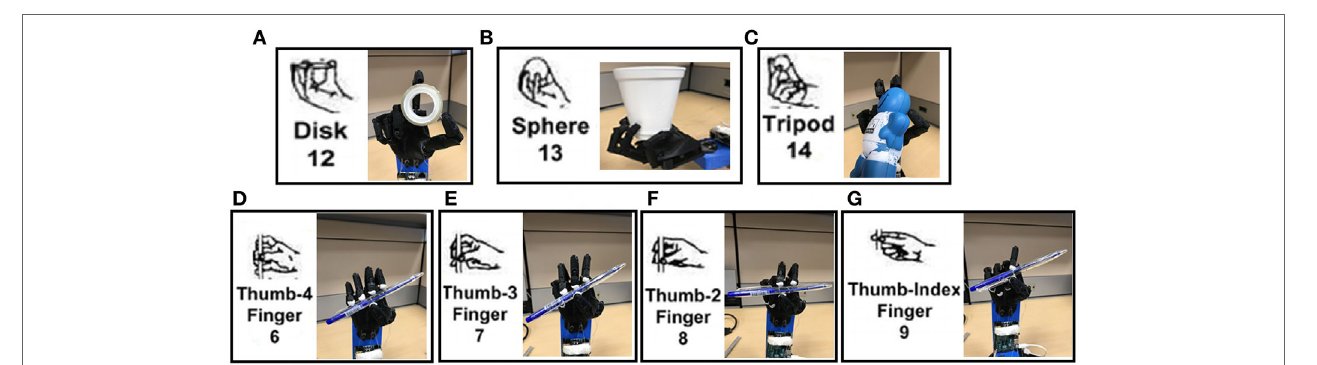
FigUre 9 | Grasping experiment (precision